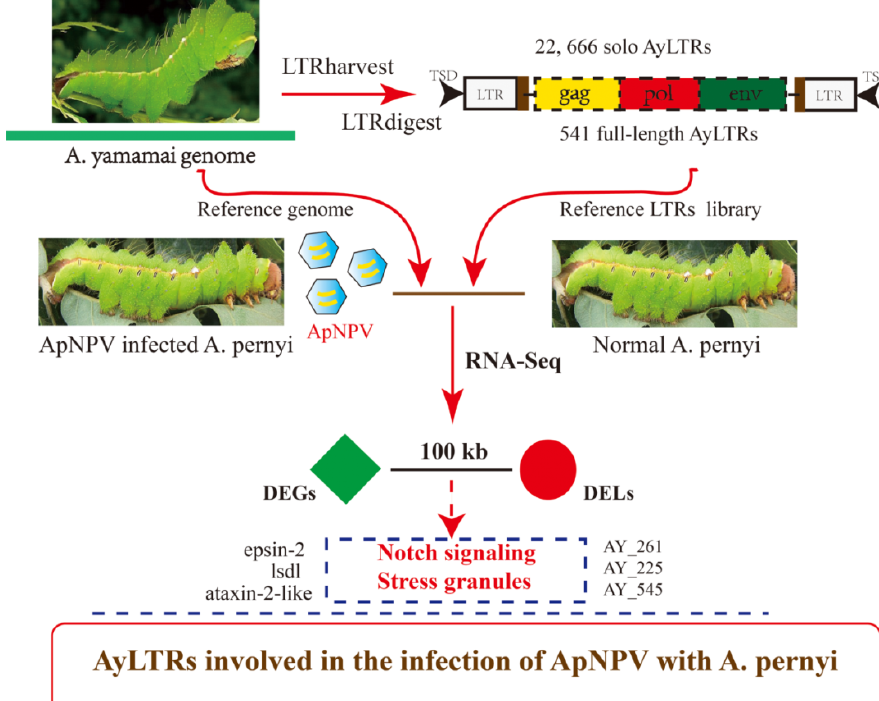
Figure 8. General overview of the study and its conclusions. Based on the genome of Antheraea yamamai [15] , which is the first draft genome in the family of saturniid moths, a wild silkworm LTR- retrotransposons library was constructed of 22,666 solo LTRs and 541 full-length LTRs. Using this information, published RNA sequence raw data of ApNPV-infected A . pernyi larval midgut and uninfected control samples [3] were analyzed to identify 12 DELs and 3779 DEGs with respect to ApNPV infection. In more detailed analysis, several DEGs, that are associated with Notch signaling and stress granule formation, are considered to be regulated in cis by DELs during ApNPV infection (Dotted line). Our study indicates a potential role for LTR-retrotransposons to regulate the host gene response during ApNPV infection of A . pernyi .